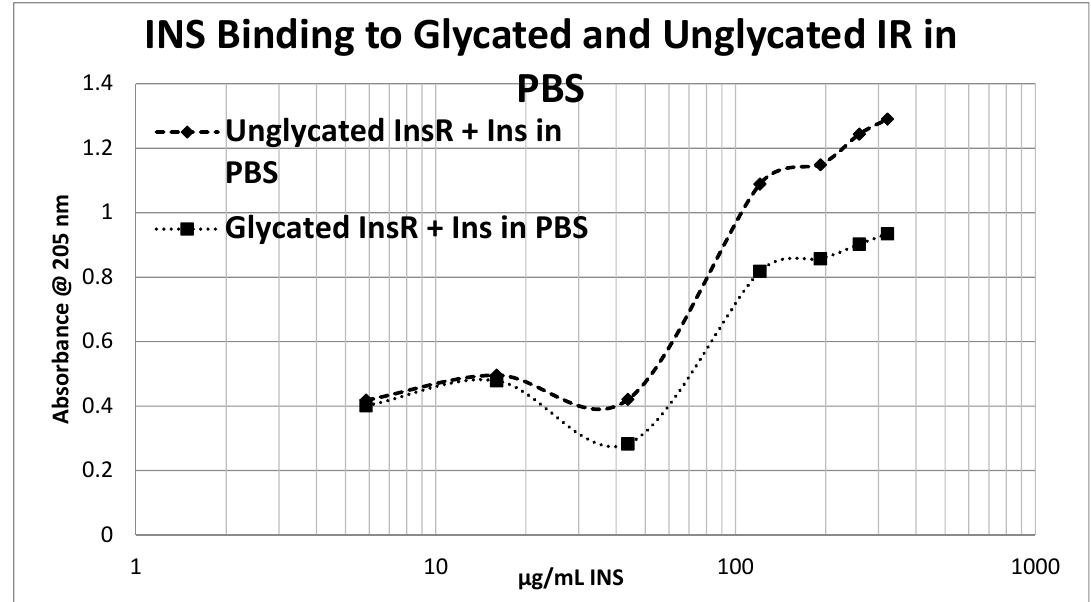
Figure 12. Insulin (INS) binding to glycated and unglycated insulin receptor (InsR) in phosphate buffered saline without glucose. The binding constant of the INS for InsR under these conditions was found to be 70 µg/mL of INS. Glycation reduced the amount of binding by almost exactly one third without appreciably altering affinity.